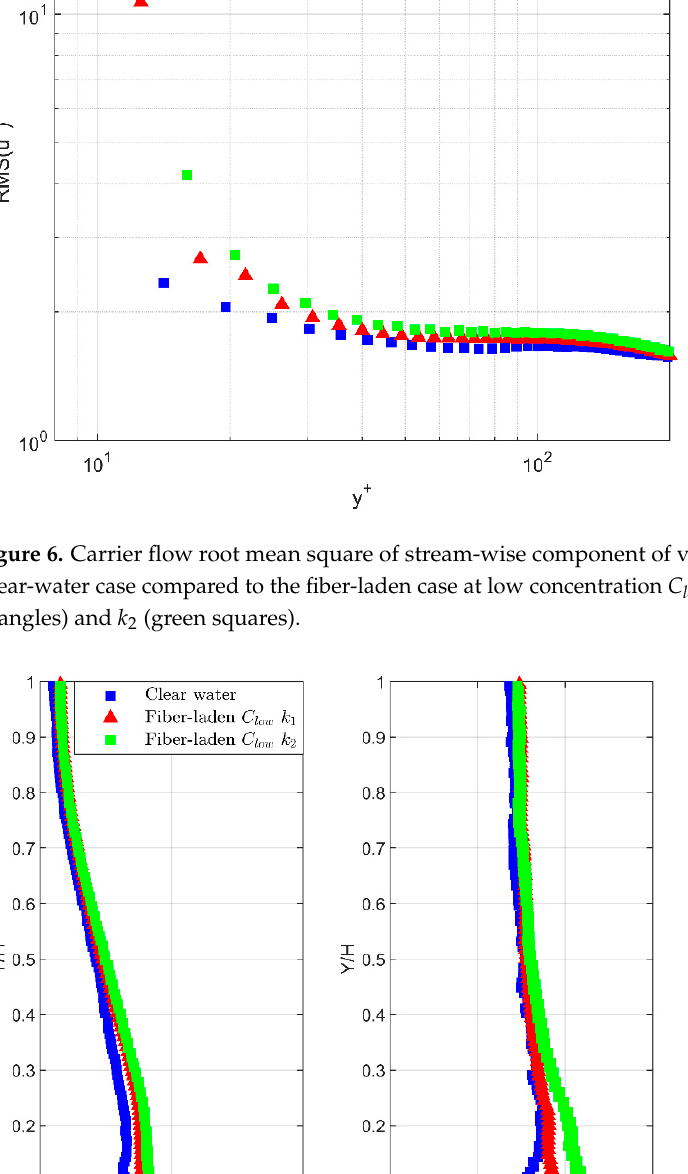
Figure 5. Carrier flow average stream-wise profile in wall coordinates. Clear-water case compared to the fiber-laden case at low concentration C low , two aspect ratios k 1 and k 2 .